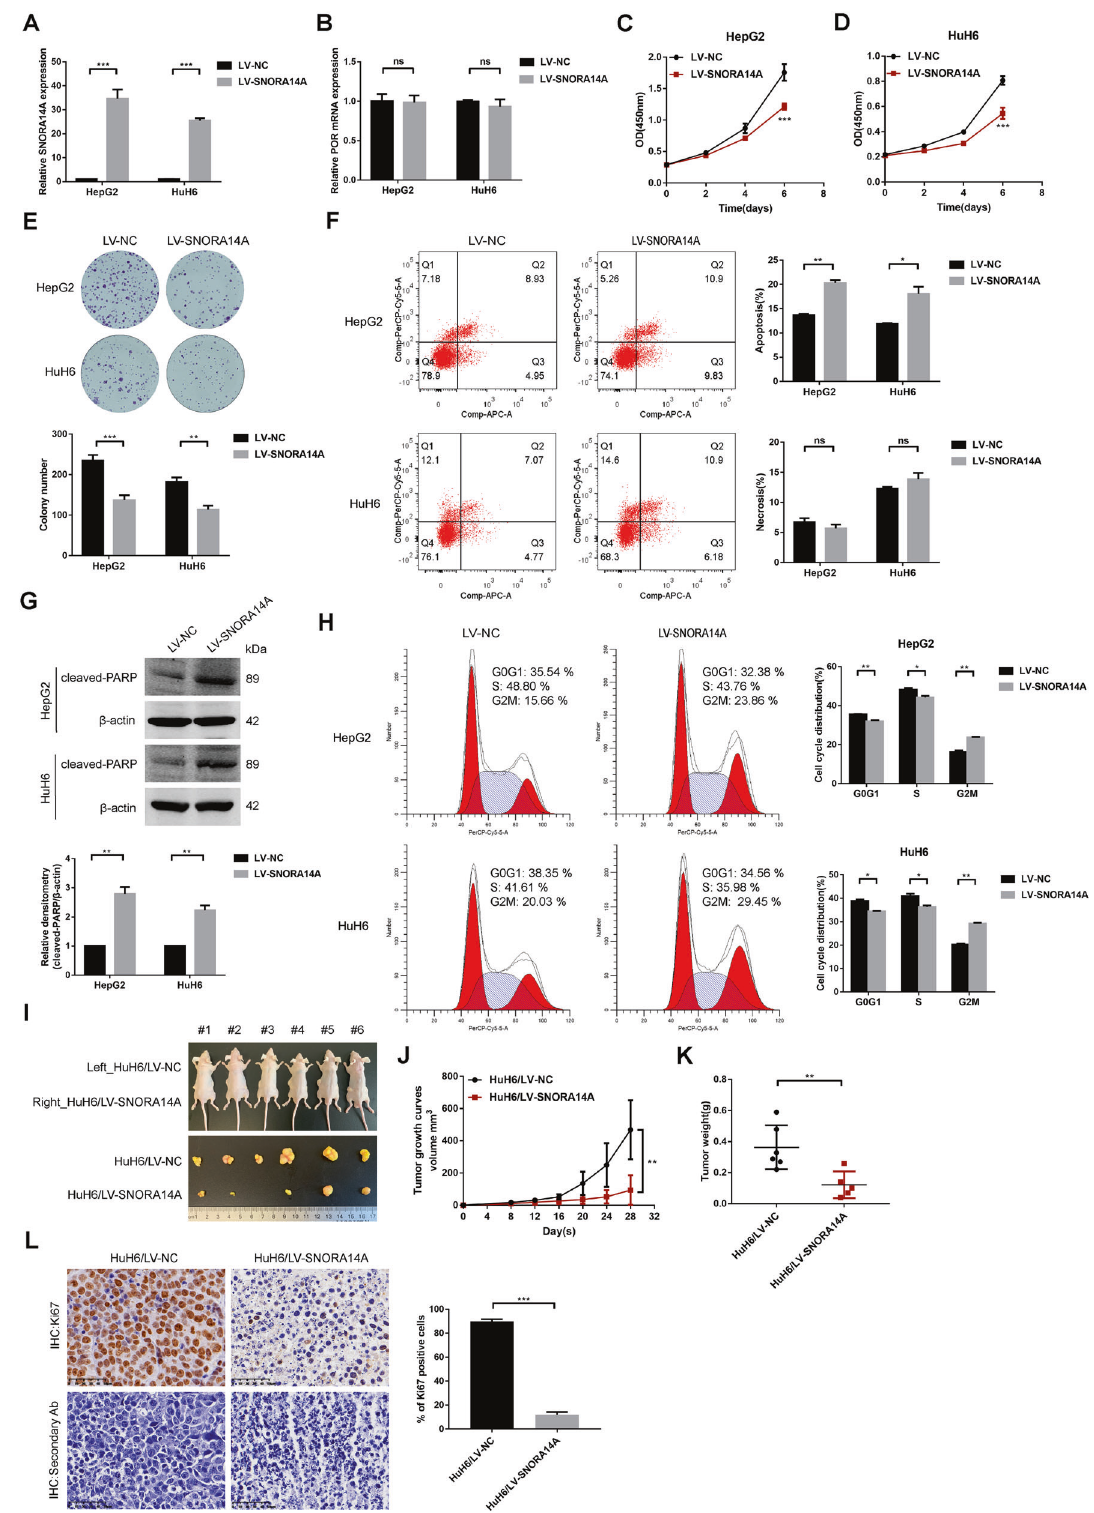
revealed no correlation between SNORA14A and POR expression levels ( r = 0.164, P = 0.347) (Fig. 2G). To further investigate how the steady-state SNORA14A level was reduced in HB, we performed RNA decay assays and found that the half-life of SNORA14A in HB cells was obviously shorter than that in THLE-2